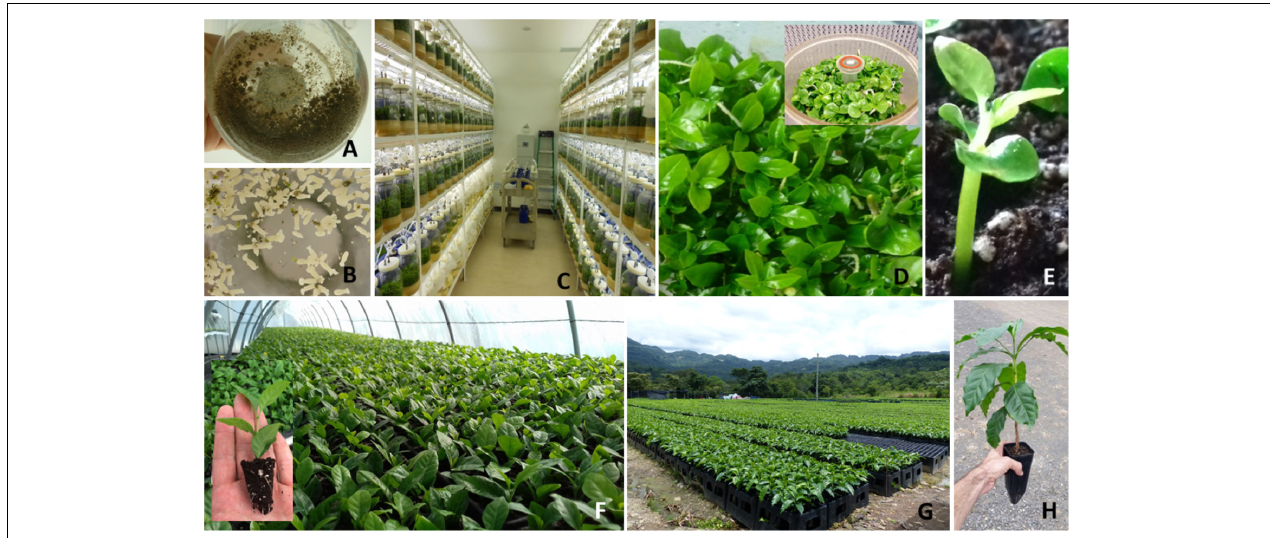
FIGURE 2 | Somatic embryogenesis of C. arabica : model of industrialization and professionalization. (A) Embryogenic cell suspension in liquid medium; (B) embryo differentiation in liquid medium ( torpedo stage ); (C) embryo development phase in TIS (temporary immersion system); (D) germinated embryos in Twin-Flask Bioreactor (above: cotyledonary embryos obtained in 1L-RITA); (E) Conversion into plantlets of pregerminated embryos onto horticultural substrate; (F) rooted cuttings in plug trays; (G) industrial hybrid nurseries with plastic pots and peat moss substrate. (H) Rooted cutting ready for field